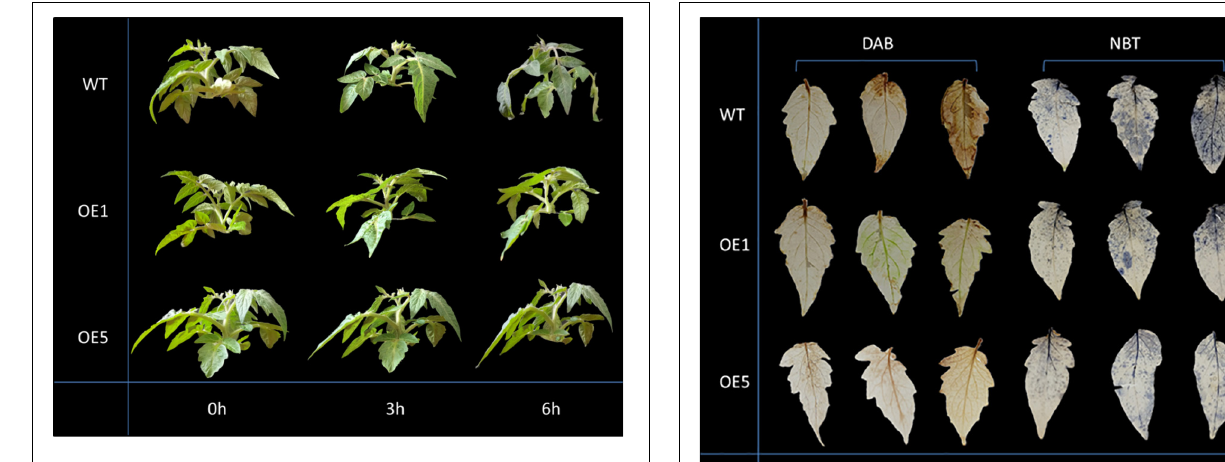
Frontiers in Plant Science |